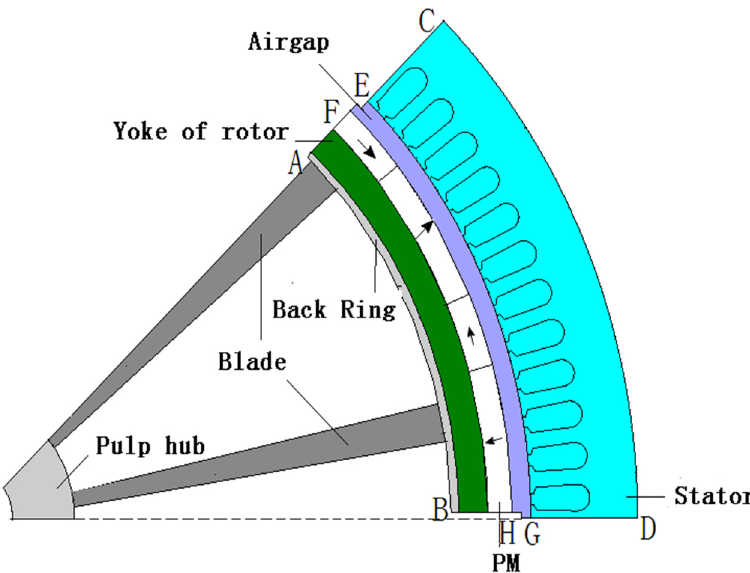
Figure 11. Simplified PM model for multifield coupled analysis [86].